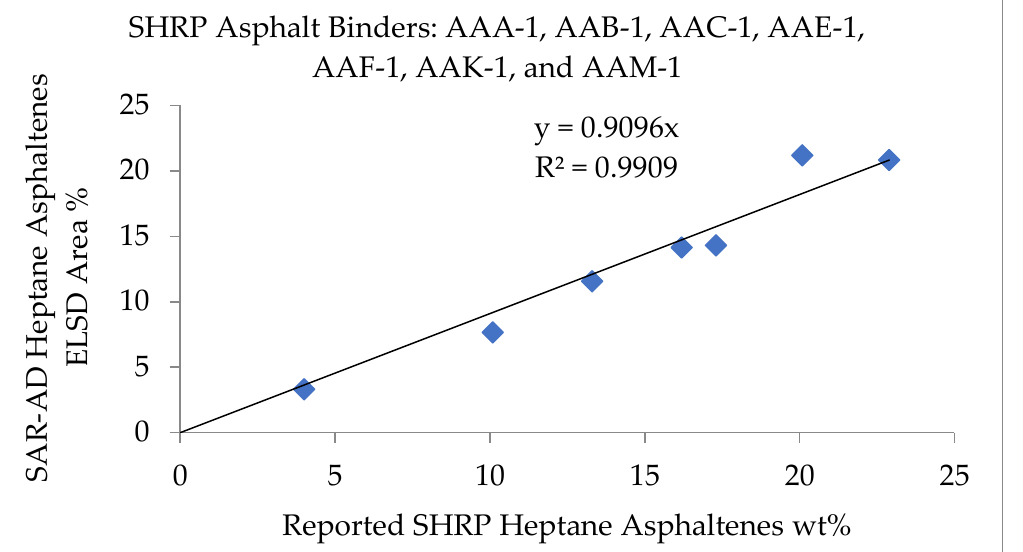
Figure 24. Correlation between SAR-AD heptane asphaltenes and gravimetric heptane asphaltenes for select SHPR core asphalt binders.